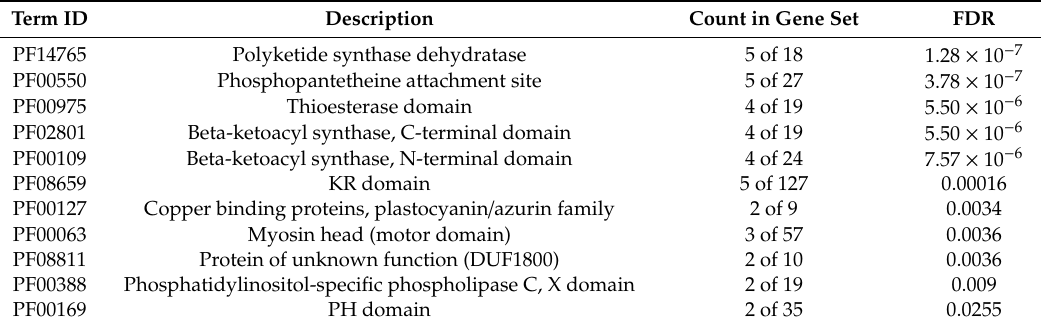
Table 1. The enriched domains of upregulated DEGs in the PFAM database.